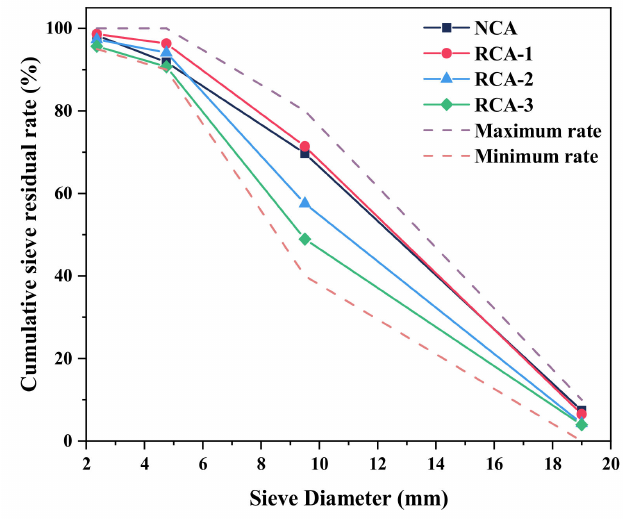
Figure 2. Grading curve of natural aggregate concrete (NCA) and